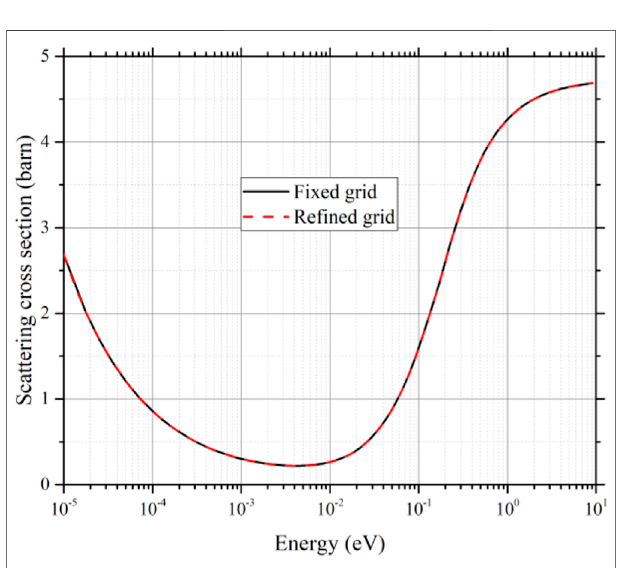
FIGURE 9 | Inelastic scattering cross sections of graphite.